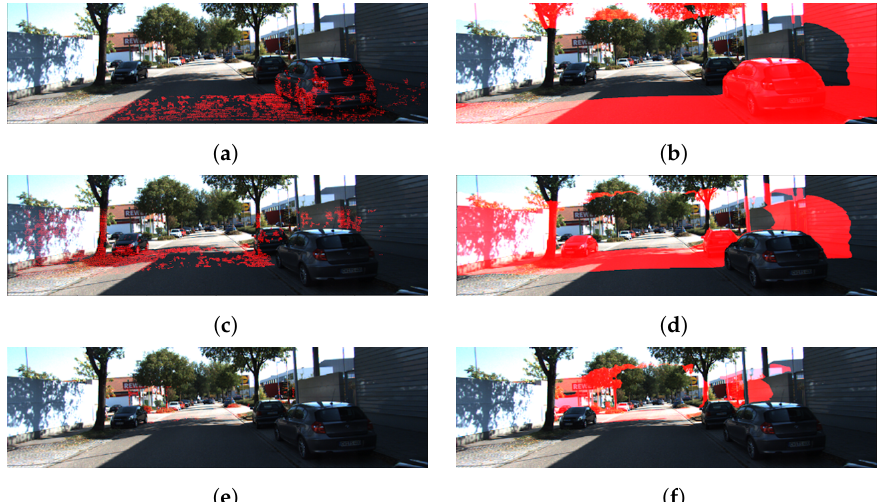
Figure 1. Depth estimation results of the KITTI test dataset for the AdaBins model trained using the KITTI training dataset (left: ground truth, right: depth estimation result). The regions shown in red in the images indicate the point groups corresponding to certain depth ranges. ( a , b ) 5–10 m, ( c , d ) 10–20 m, ( e , f ) 20–40